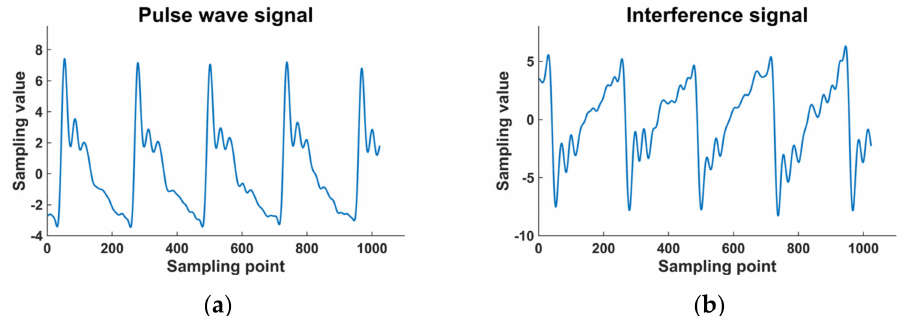
Figure 3. ( a ) Pulse wave signal. ( b ) Interference